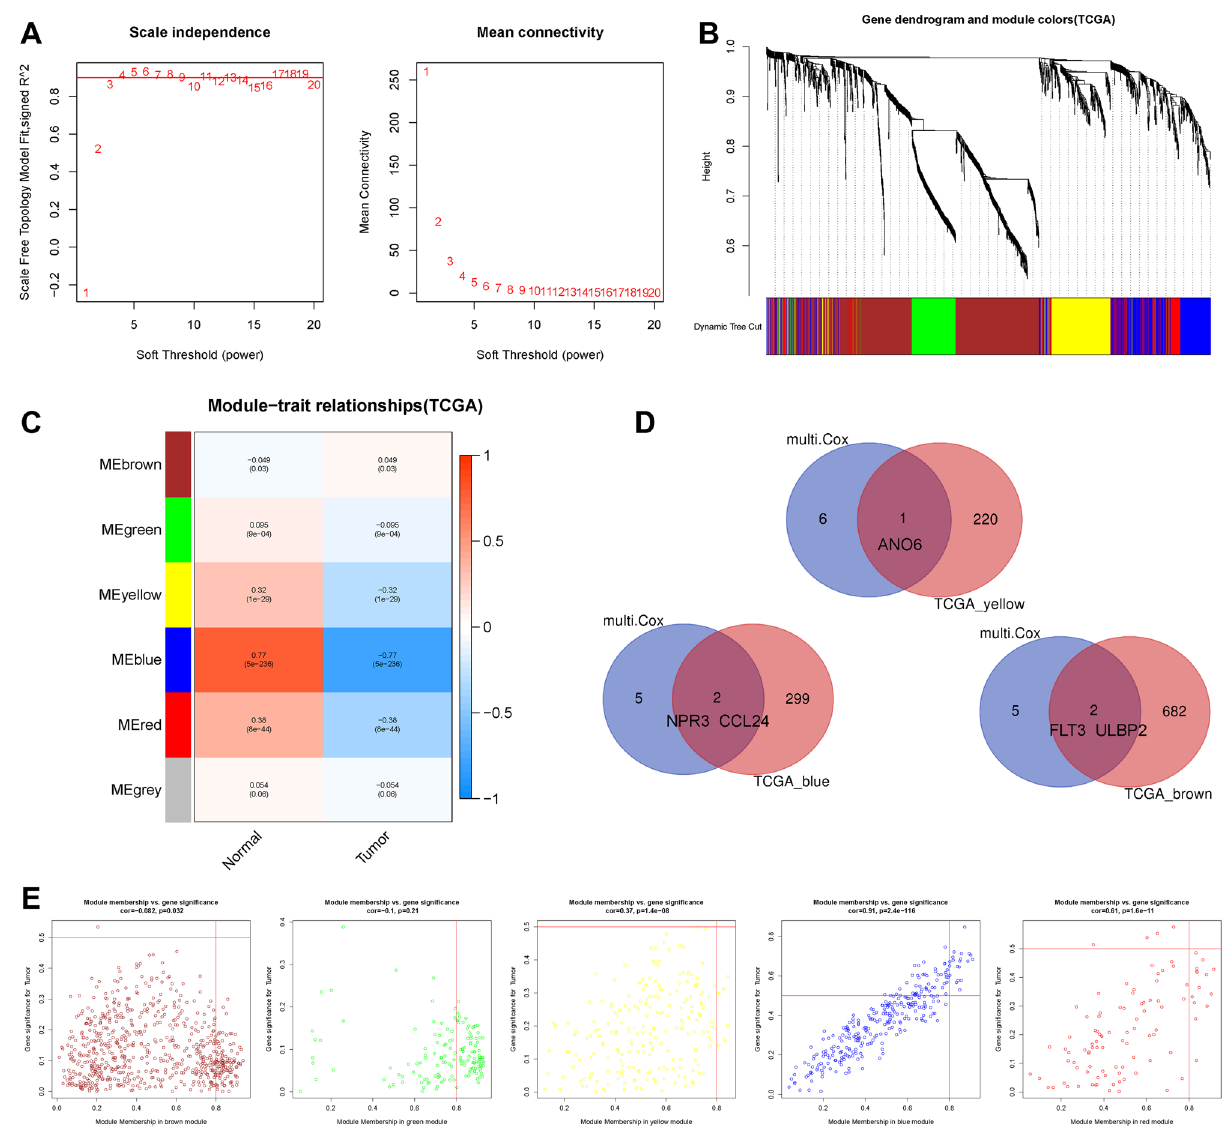
Figure 4. Weighted gene co-expression network analysis (WGCNA) and identification of candidate immune-related hub genes. ( A ) Analysis of network topology for various soft-thresholding powers. ( B ) Gene dendrogram and module colours. ( C ) Immune-related genes (IRGs) in the brown, green, and yellow modules were significantly correlated with BC progression. ( D ) Venn diagram results confirmed that IRGs ANO6, NPR3, CCL24, FLT3, and ULBP2 were also recruited to construct our prognostic risk model. ( E ) Module membership (MM) vs. gene significance (GS) analysis of 7 modules showed that MM was significantly correlated with GS in brown, yellow, blue, and red modules. WGCNA weighted gene co-expression network analysis, IRG immune- related gene, MM , module membership, GS gene